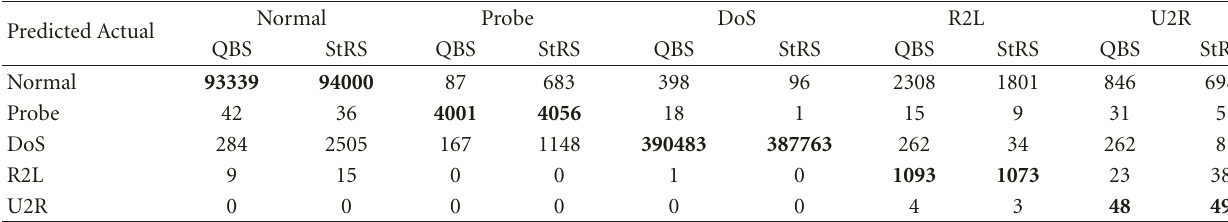
Table 2: The confusion matrix of the training dataset.